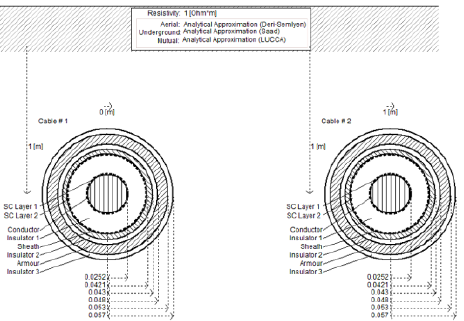
Fig. 15. Cross-section and configuration of the XLPE insulated HVDC cable